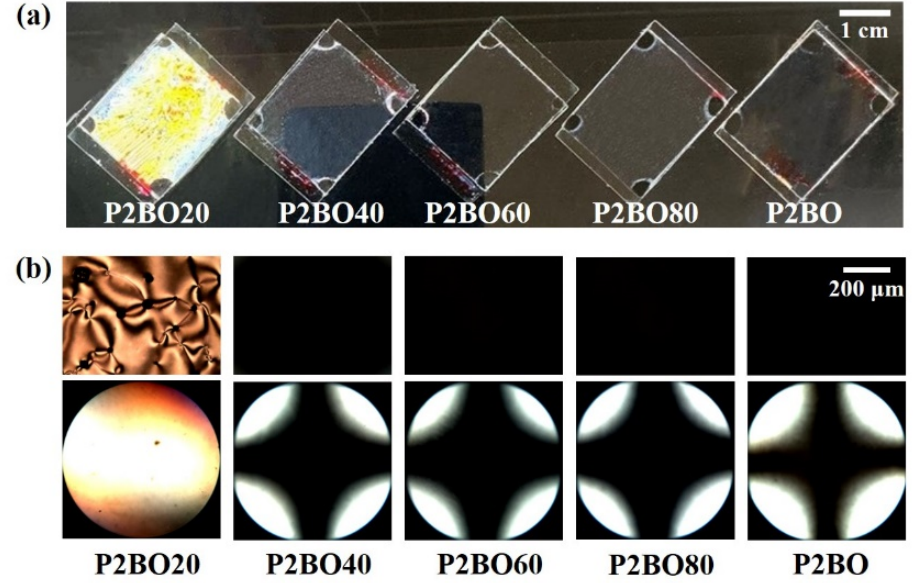
Figure 5. ( a ) Photograph, ( b ) orthoscopic (top) and conoscopic (bottom) polarized optical microscopy (POM) images of the LC cells fabricated with P2BO# (P2BO20, P2BO40, P2BO60, and P2BO80) and P2BO.